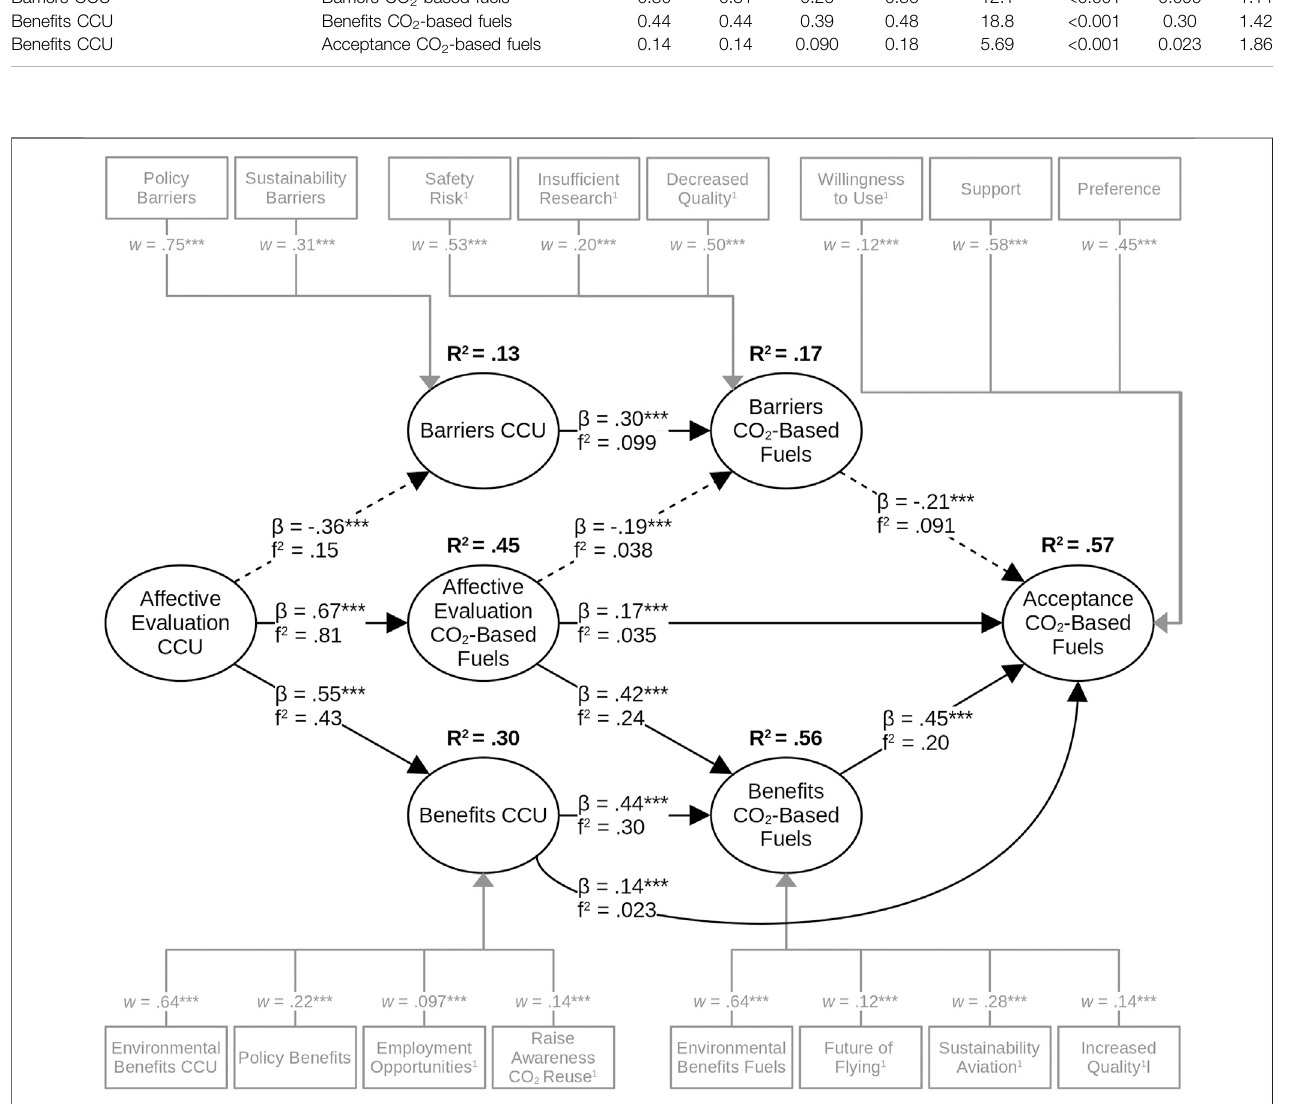
Frontiers in Energy Research |